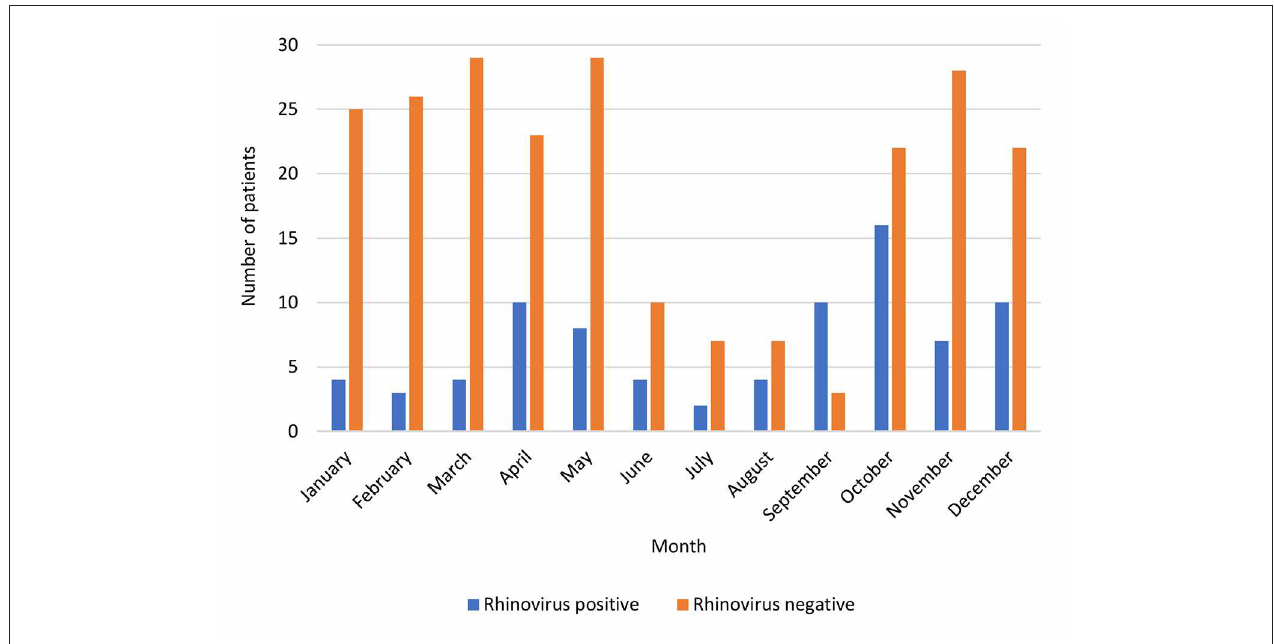
FIGURE 2 | The cumulative monthly numbers of RV-positive and RV-negative pneumonia inpatients during years